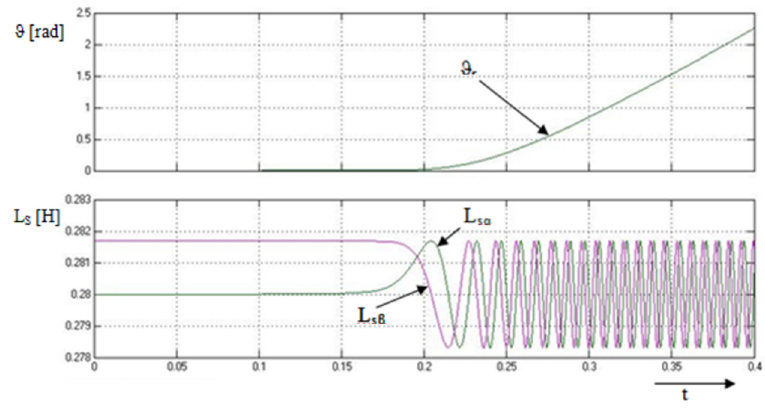
Figure 6. Course of stator inductance during ASM start-up with NSDR. The value L 1 expresses the difference between the maximum and minimum value of the stator inductance depending on the rotor position.